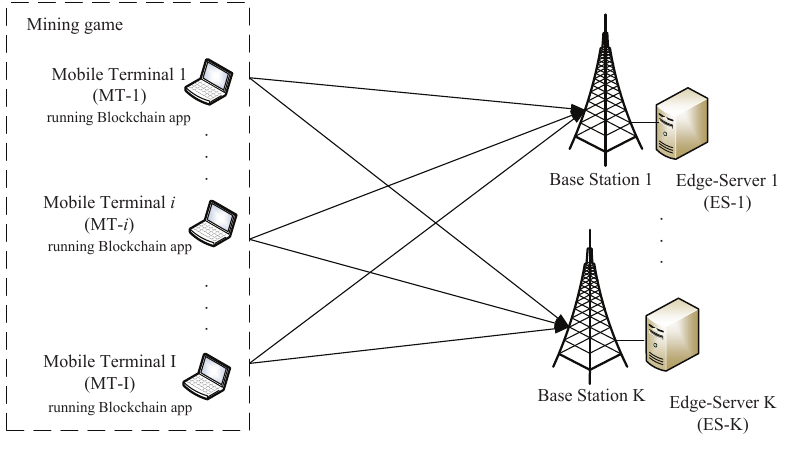
Figure 1. System model: a group of mobile terminals offload computational workloads to the edge